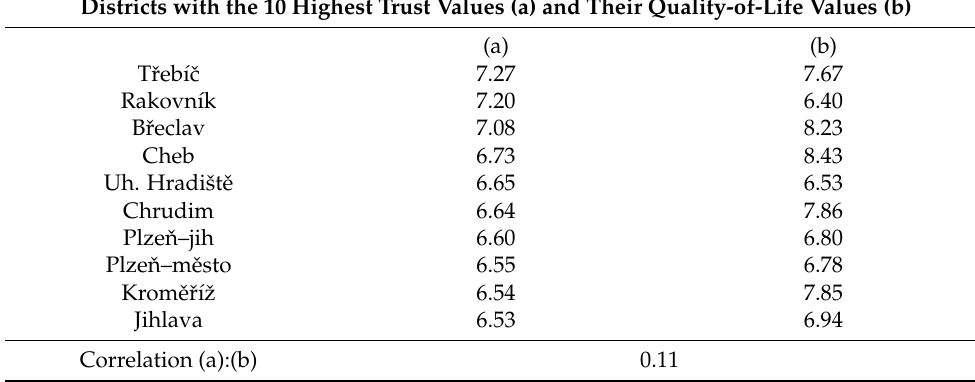
Table 5. Districts with the highest values of trust life and corresponding quality-of-life values. Districts with the 10 Highest Trust Values (a) and Their Quality-of-Life Values (b)